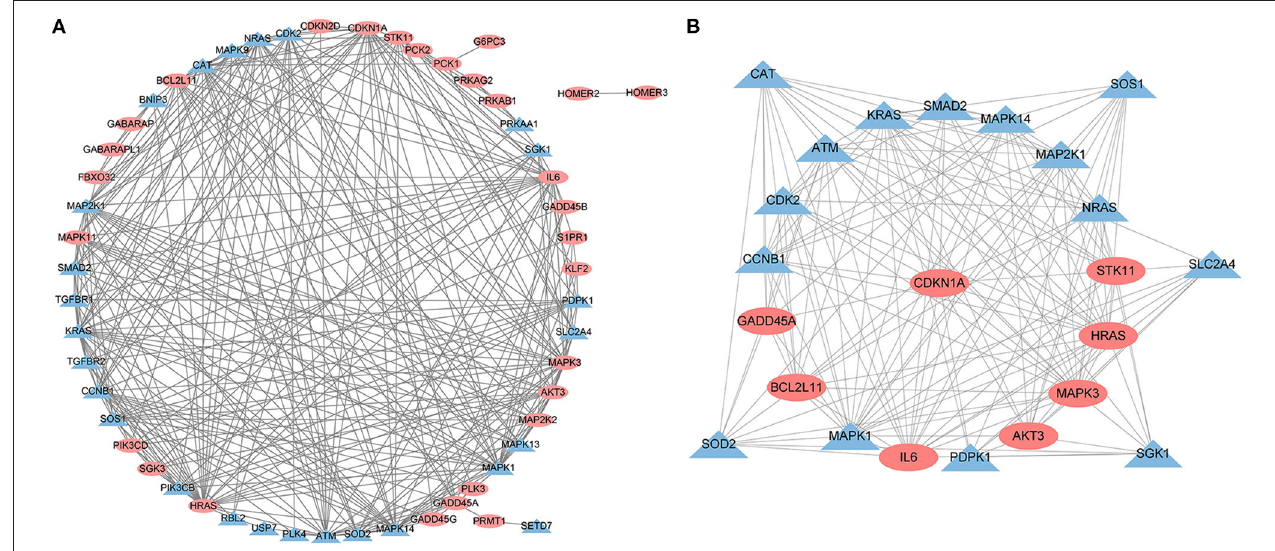
FIGURE 8 | The PPI analysis of DEGs in the FoxO signaling pathways. (A) The entire PPI network of annotated interactions between genes. (B) A sub-network module for the hub genes. Red circles represent up-regulated genes, blue circles represent down-regulated genes.